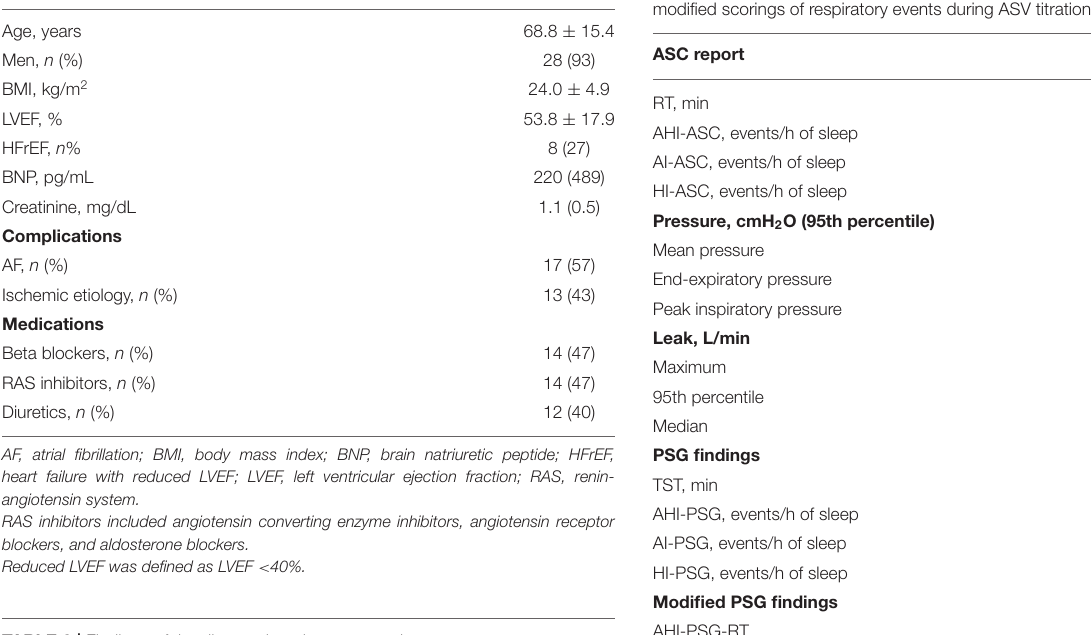
TABLE 1 | Patient characteristics.